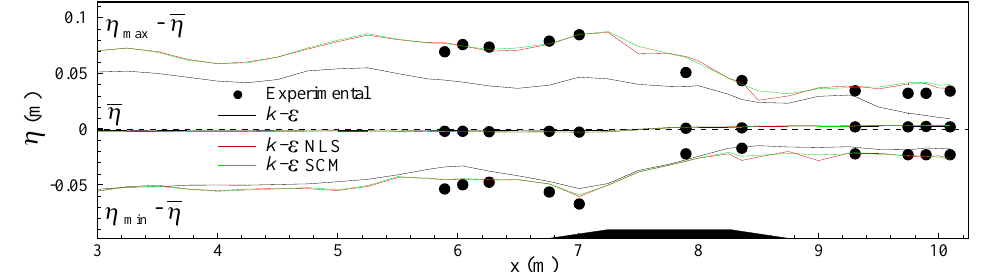
Figure 18. Maximum and minimum wave height envelopes and mean water level of k- ε , k- ε NLS and k- ε SCM models and the experiment (dash line indicates the still water level), T p = 2.4 s, H s = 0.10 m.